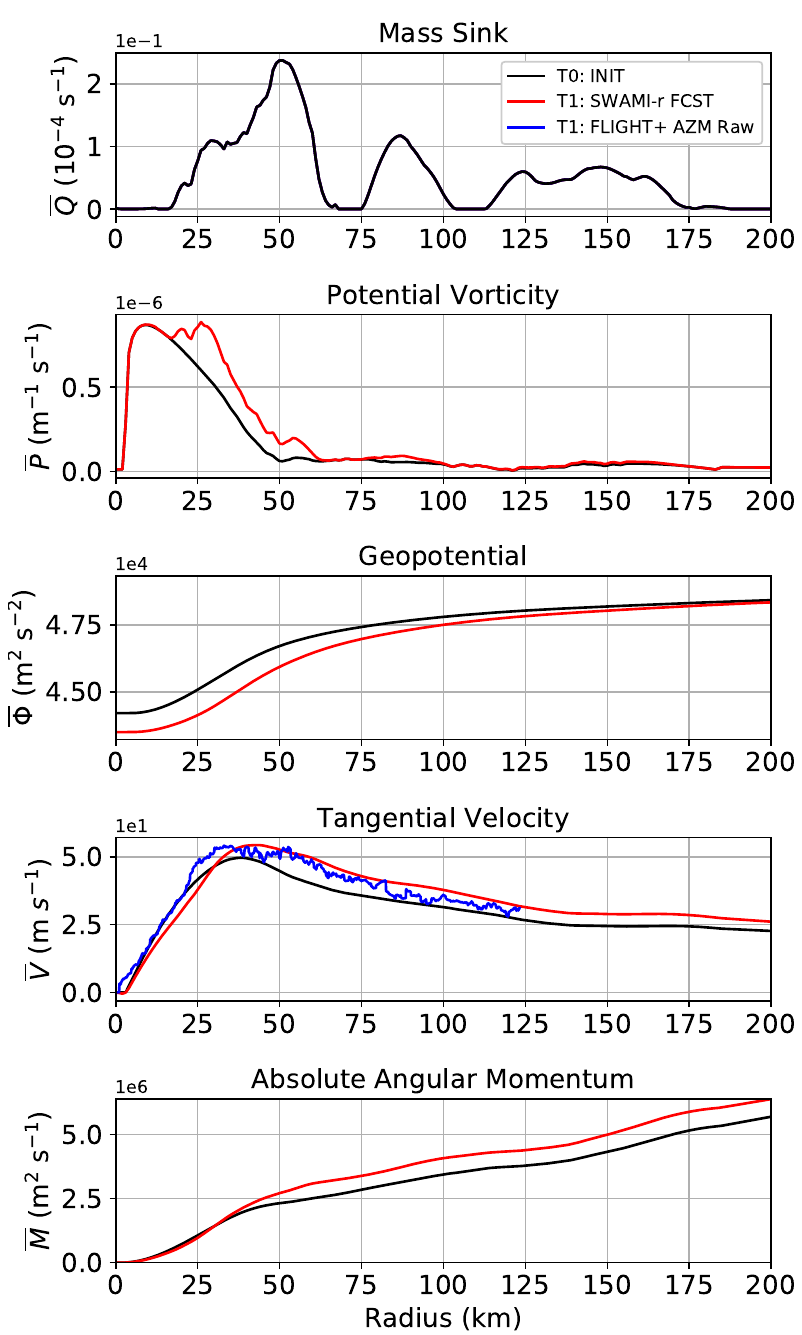
Figure 7. Slow intensifying event of Hurricane Joaquin from 1 October 2015 12:20:48 to 1 October 2015 23:57:20. The five panels show the SWAMI initialization and forecasts of PV , Φ , v , M , and the mass sink forcing Q . Verification of the SWAMI azimuthal mean tangential velocity forecast using the 1 October 2015 23:57:20 azimuthal mean group is shown in the blue curve on the fourth